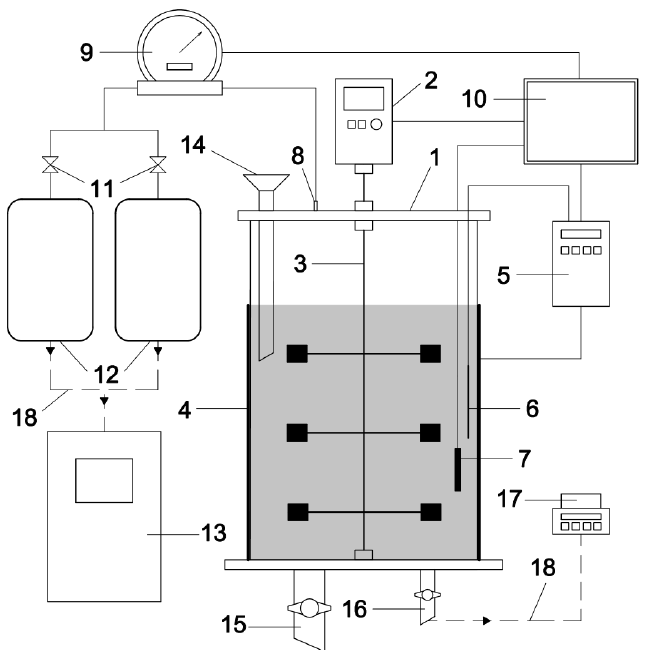
Figure 1. Research diagram: 1—Biogas reactor; 2—Stirrer drive; 3—Stirrer; 4—Electric heating pad with insulation; 5—Heating controller; 6—Temperature sensor; 7—pH electrode; 8—Biogas output port, 9—Gas volume meter; 10—Monitor and computer; 11—Biogas valves; 12—Two gas bags; 13—Biogas analyser; 14—Feeding port; 15—Substrate drain valve; 16—Digestate sampling port; 17—Moister meter; 18—Manual operation (biogas and digestate convey to analysis).